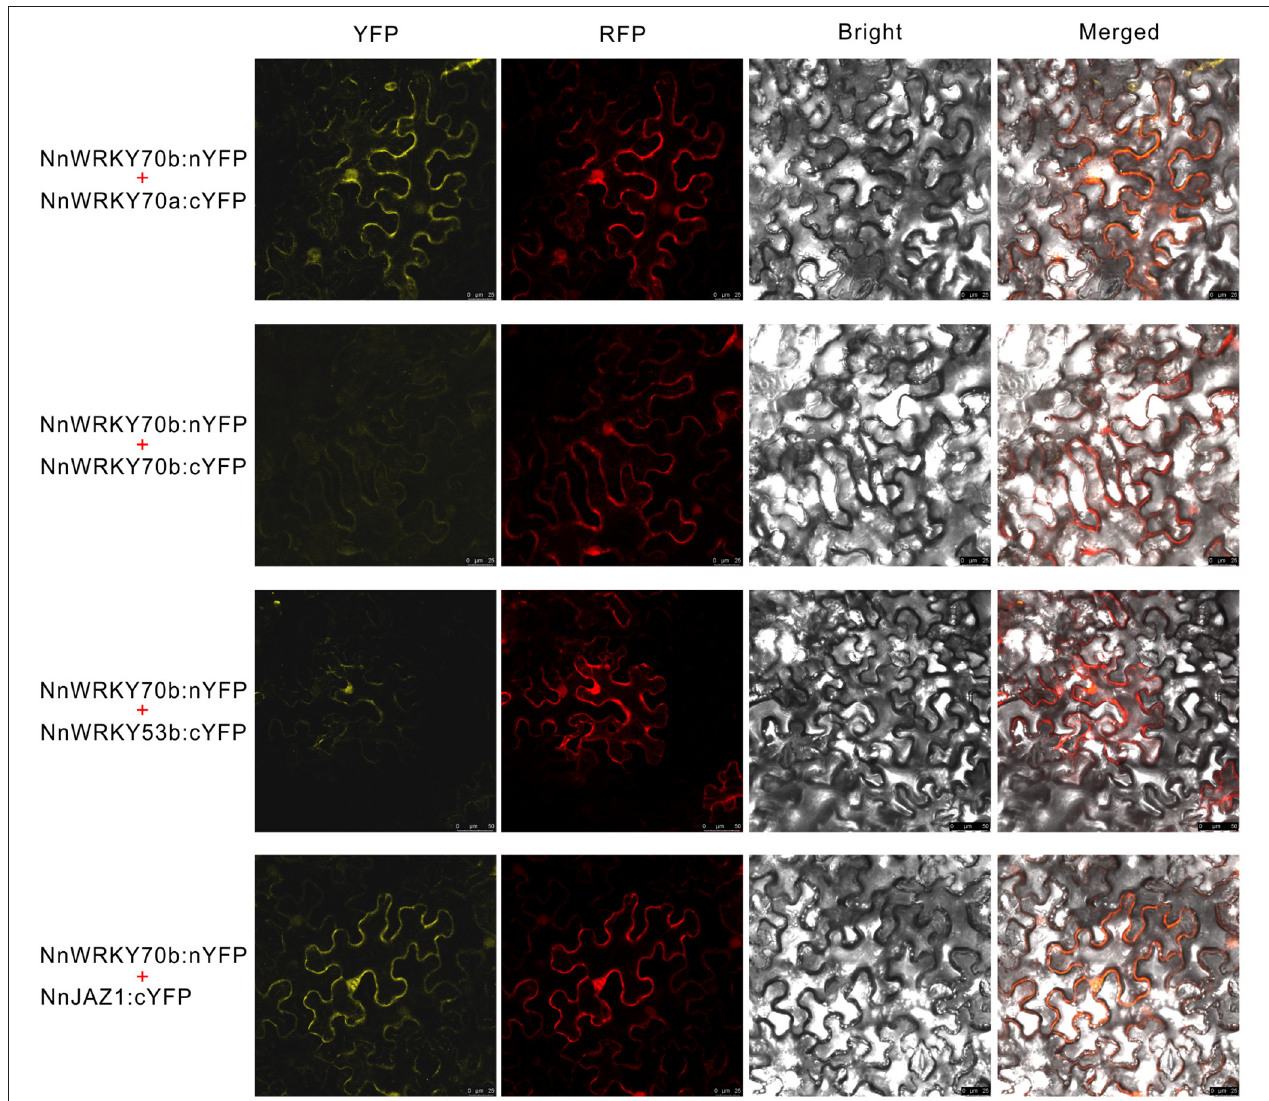
FIGURE 7 | Bimolecular Fluorescence Complementation (BiFC) assays showed that NnWRKY70b could interact with NnWRKY70a, NnWRKY53b, and NnJAZ1 in vivo . BiFC assays were conducted with a 2in1 system based on the splitting of enhanced yellow fluorescent protein (EYFP). Two fusion proteins were expressed with the same pBiFCt-2in1-CN vector, and a soluble monomeric red fluorescent protein (mRFP) was expressed in the same vector as an internal marker for transformation and expression